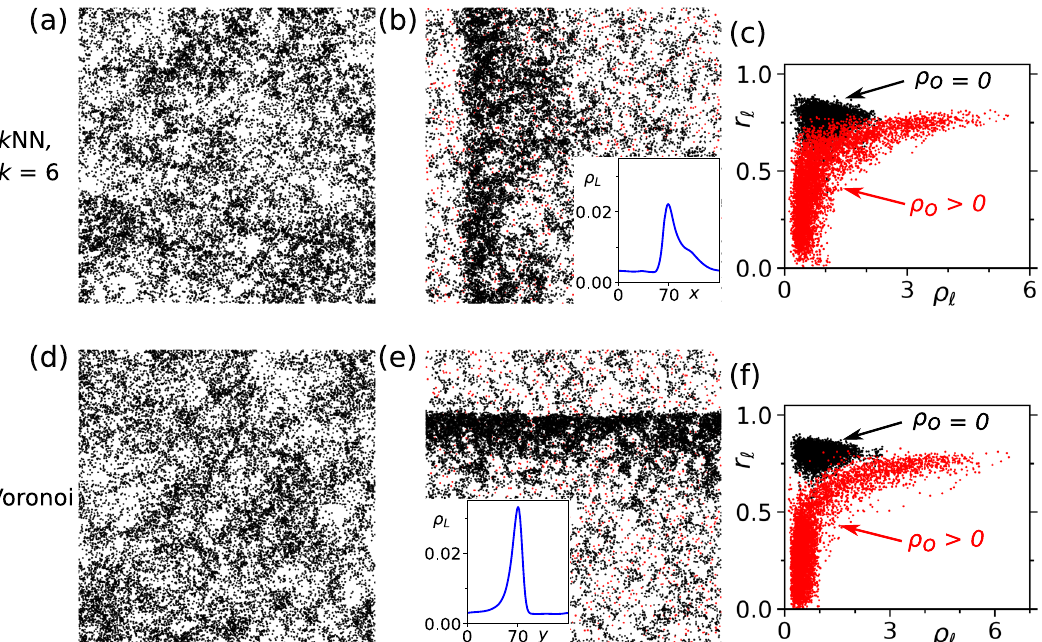
Fig. 1 The role of heterogeneity in fl ocking with topological interactions. Panels a – c corresponds to k -nearest neighbors interaction ( k NN, k = 6 where k is the number of neighboring objects), and panels d – f are for Voronoi interaction. Snapshots indicate macroscopic con fi gurations, a , d in obstacle-free environments, where obstacle density ρ o = 0, and b , e in complex environments, with obstacle density ρ o = 0.051. Black and red dots represent particles and obstacles, respectively. The insets in b , e show 1D band pro fi les, that is 1D particle density ρ L along the moving direction. c , f Local order ( r ℓ ) vs local density ( ρ ℓ ) measured in small cells of size l = 14 in a simulation box with linear size 140 corresponding to the systems in previous panels (see “ Methods ” for details). Black scatters are for homogeneous, and red scatters are for heterogeneous environments. Noise intensity is fi xed at η = 0.65